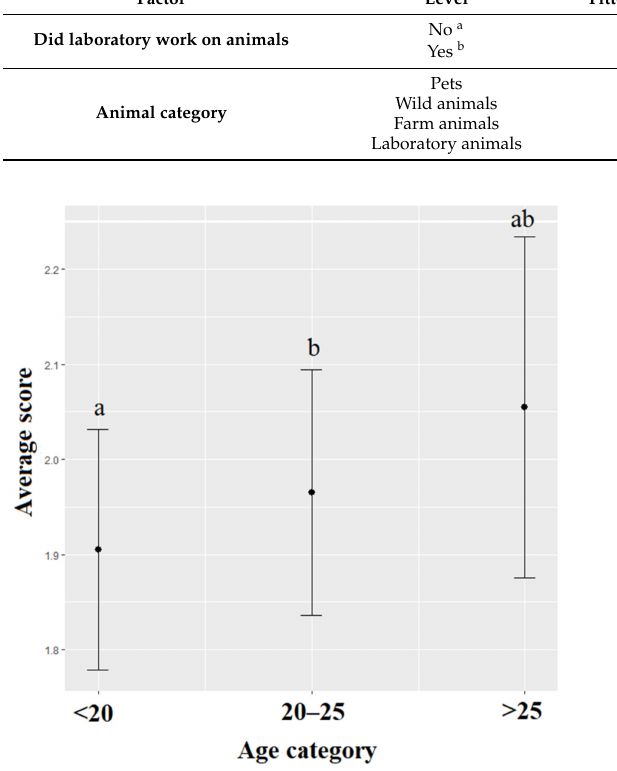
Figure 4. Means and 95% confidence intervals of scores towards the Five Freedoms model depending on the students’ age. Means and 95% confidence intervals have been back-transformed from a log scale. Different letters represent significant differences (Wald chi-square with Bonferroni correction).